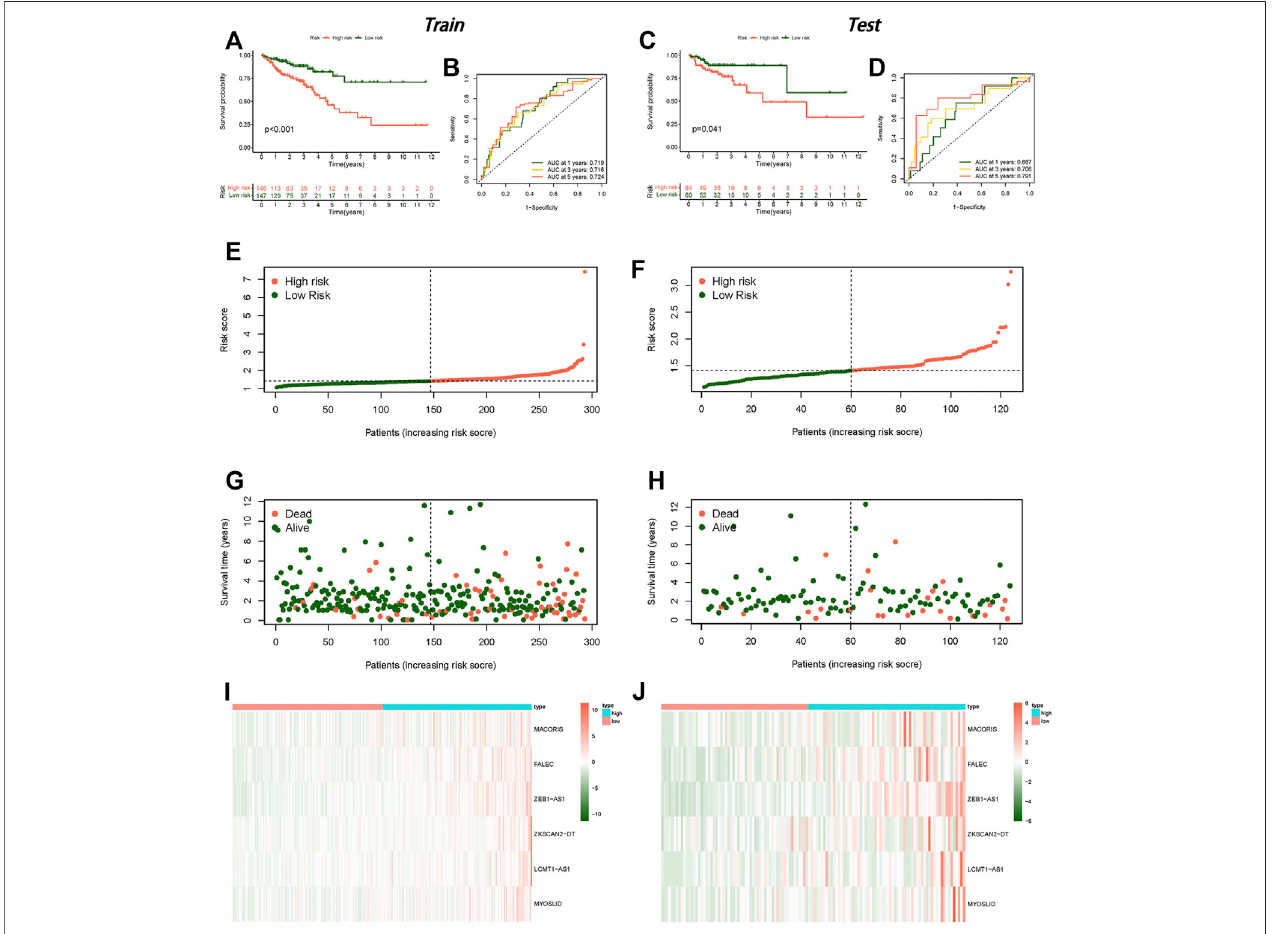
FIGURE 3 | Establishment of a risk model for necroptosis-related lncRNAs in colon cancer. (A) Kaplan – Meier curve for OS in the training group. (B) ROC curve in the training group. (C) Kaplan – Meier curve forOSin thetesting group. (D) ROCcurve in thetesting group. (E) Risk scoredistributioninthe training group. (F) Risk score distribution in the testing group. (G) OS status in the training group. (H) OS status in the testing group, (I) Heat map in the training group. (J) Heat map in the testing group.